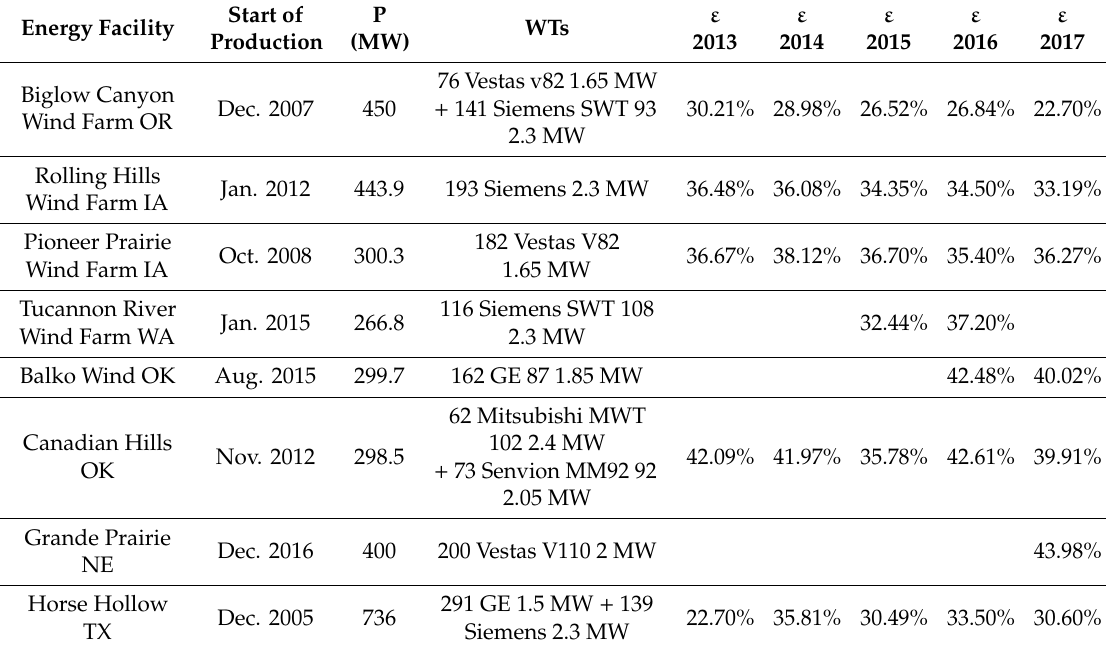
Table 8. Data of other WEF of capacity > 250 MW listed as a single